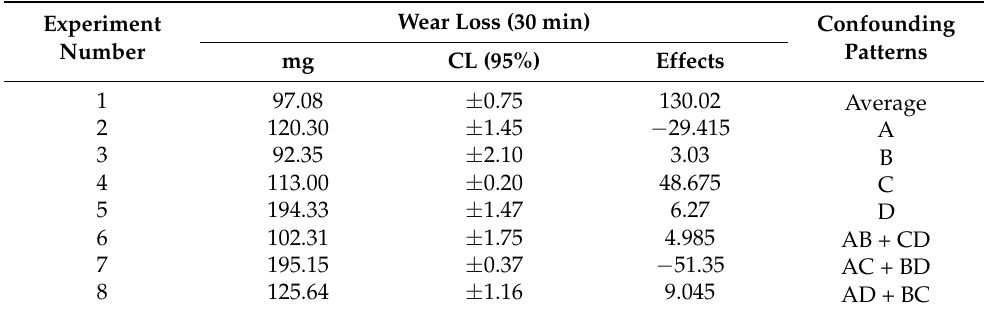
Table 6. Loss of material (mg.) after 30 min of a continuous abrasive wear test conducted in accordance with the ASTM G40-92 standard.